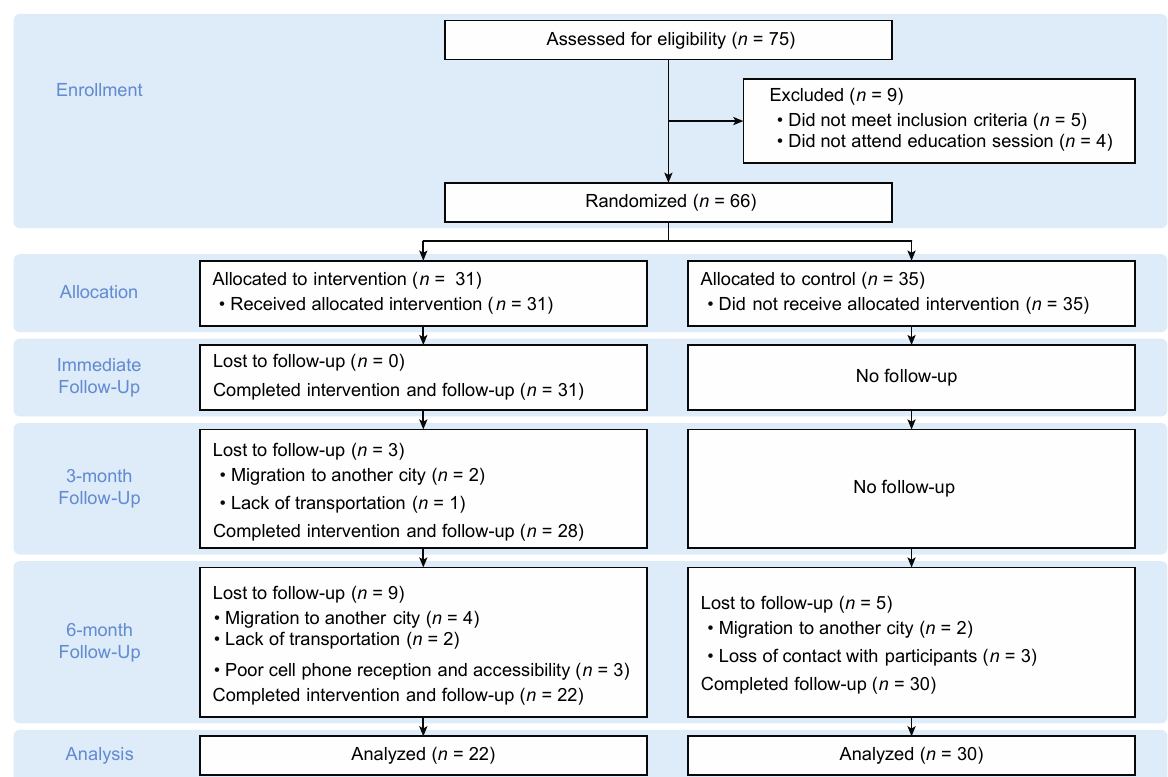
Table 2. Multivariate analyses of the predictors of the DMFT/dmft outcome. Outcome Parameter Estimate 95% Confidence Interval p